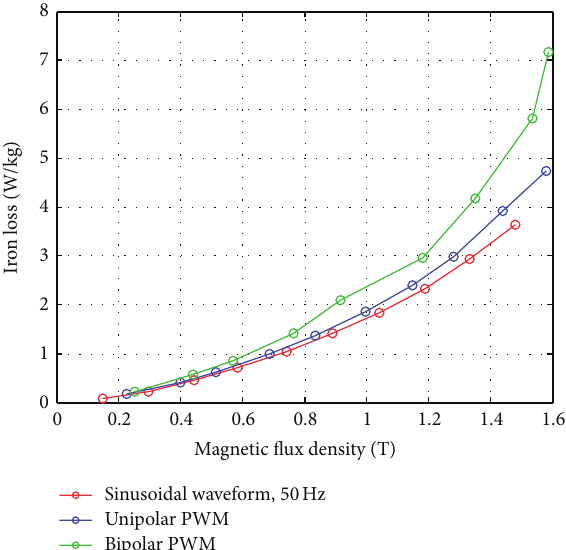
Figure 20: Iron losses for a sinusoidal waveform and PWM (with 𝑚 𝑎 = 0.9 and 𝑚 𝑓 = 20 ) obtained using the new toroidal frame.